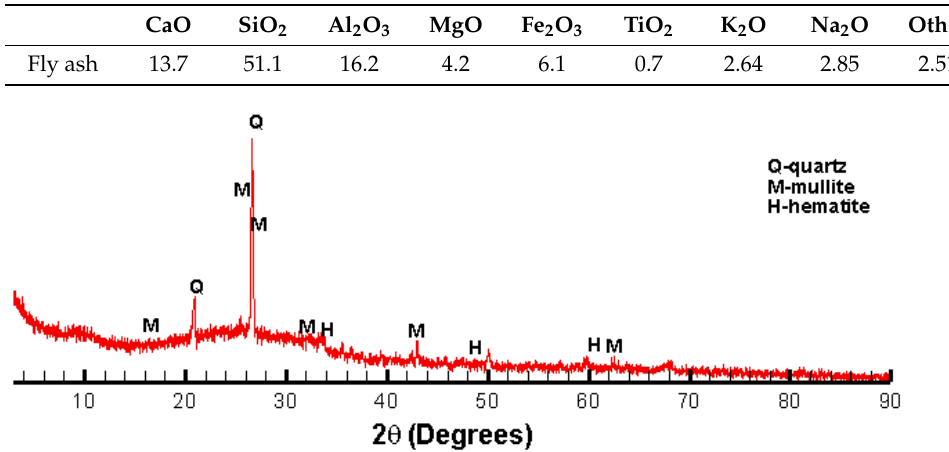
Table 1. Chemical composition of the used fly ash.